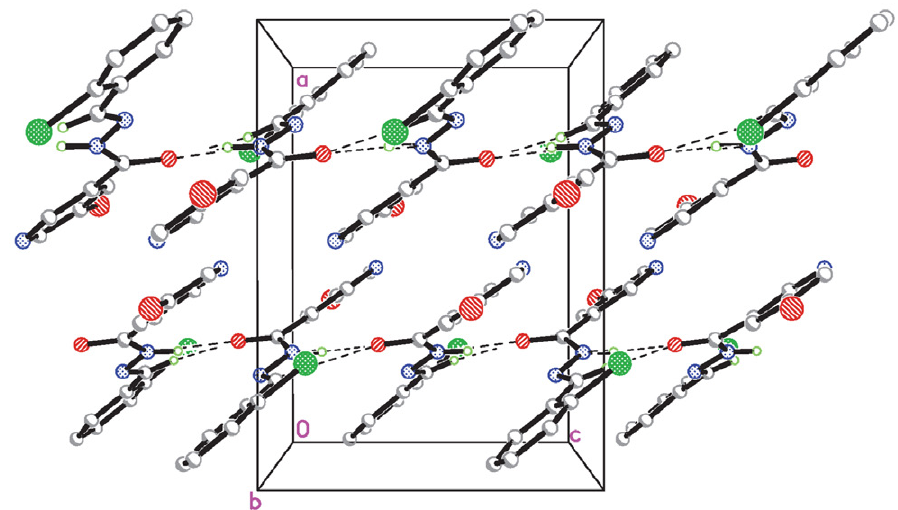
Figure 3. Molecular packing of 1 , viewed along the b axis. Hydrogen bonds are drawn as dashed lines.